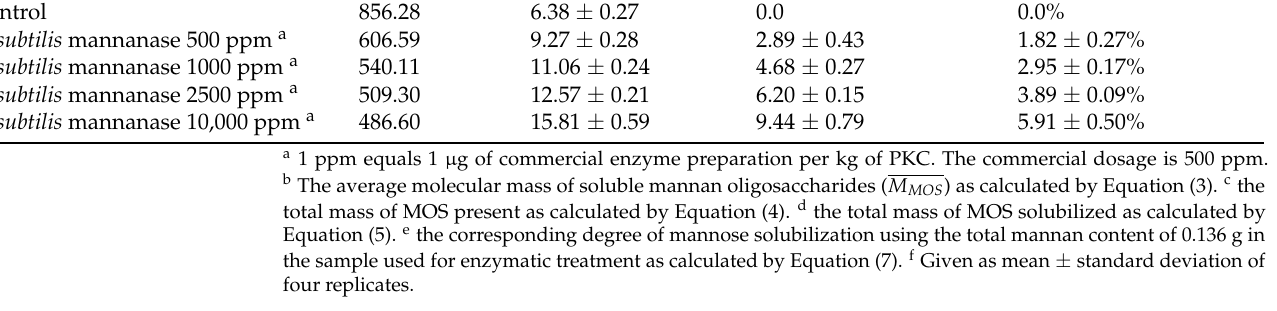
Figure 3. Characterization of mannans released by enzymatic treatment: ( A ): concentration of soluble mannans in treated samples. ( B ): average degree of polymerization (DP) of soluble mannans in control and treated samples.